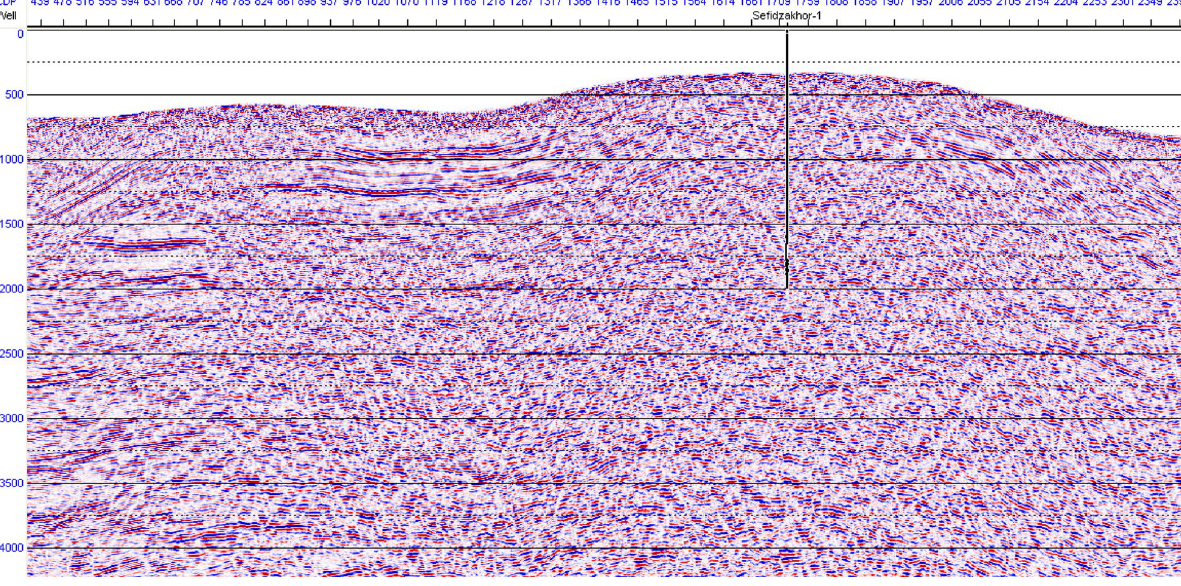
Fig. 2 Seismic section of line 8341 Sefid-Zakhor gas